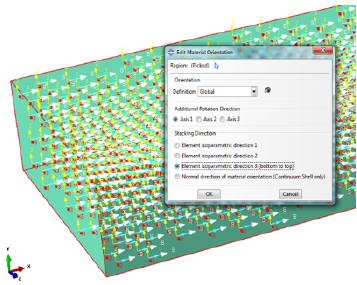
Figure 6. Specimen with global fibre